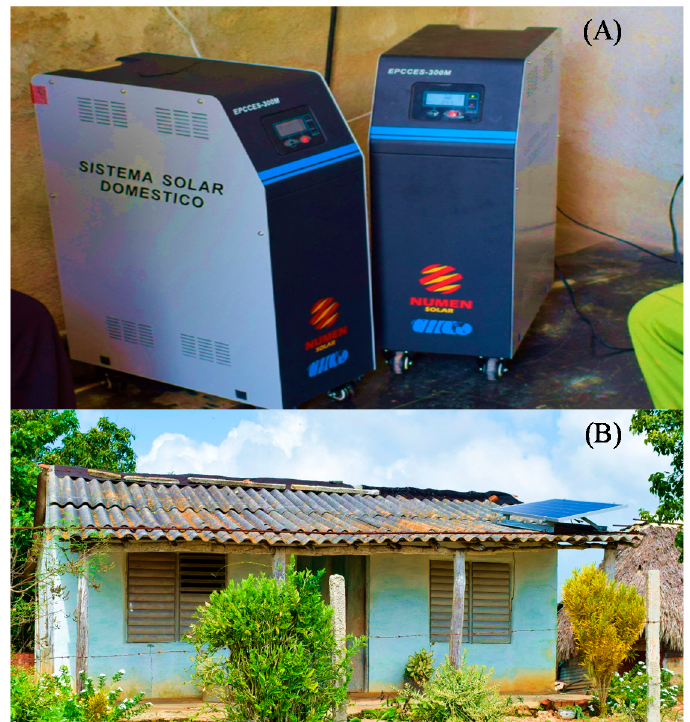
Figure 6. Portable solar system installed in Río Abajo, inside ( A ) and outside ( B ) the household.